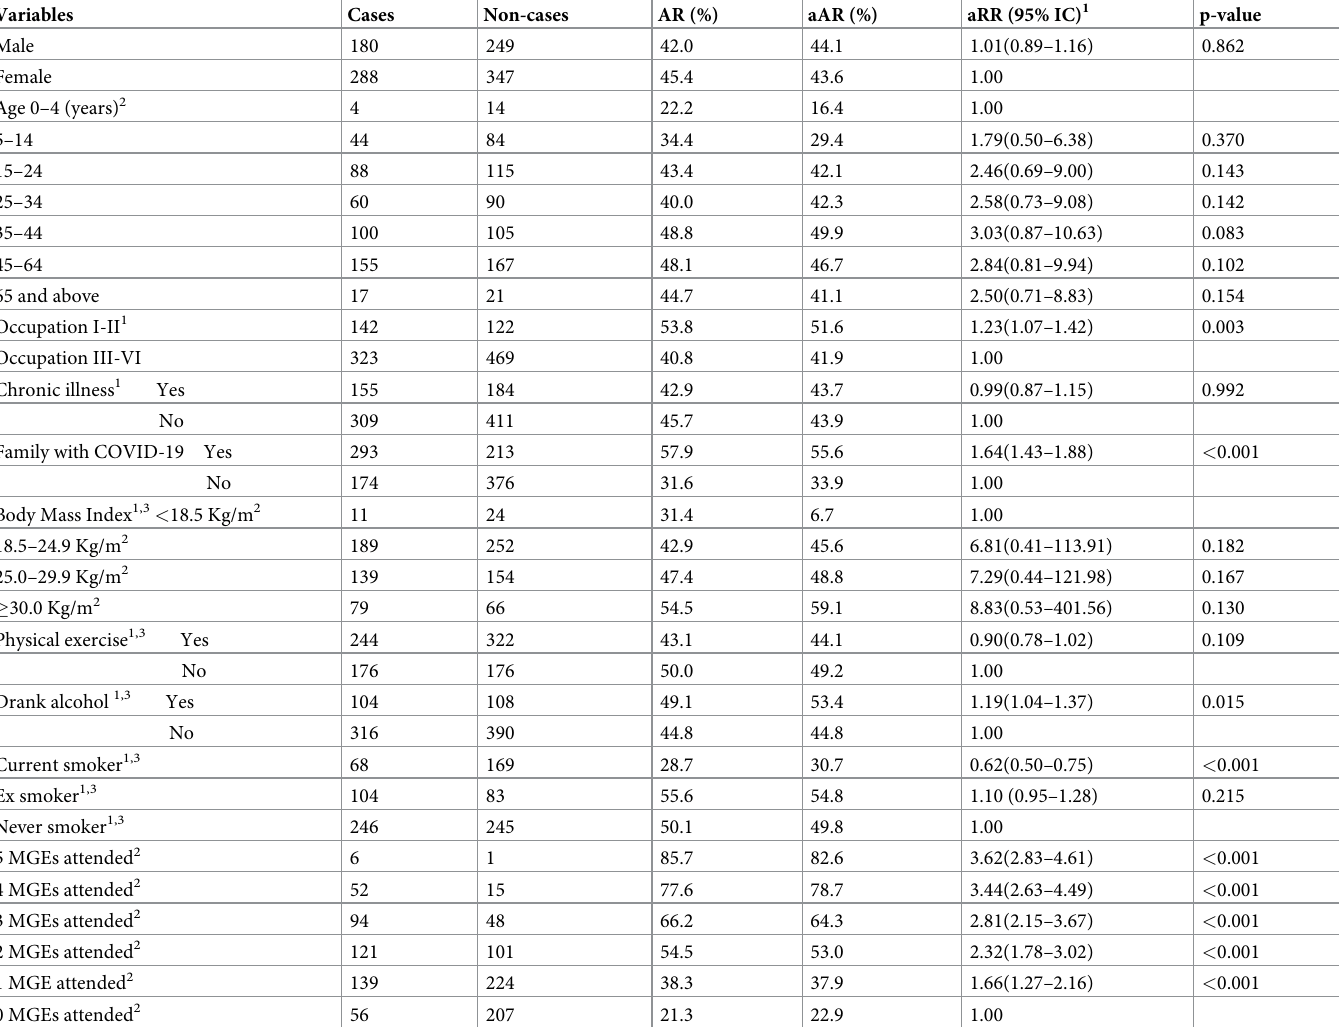
Table 7. Sensitivity analysis. Participants with laboratory tests of SARS-CoV-2 and mass gathering event (MGEs) attendance, attack rate (AR) adjusted AR (aAR), and adjusted (aRR). Confidence interval (CI). From March 6 to 31, 2020,